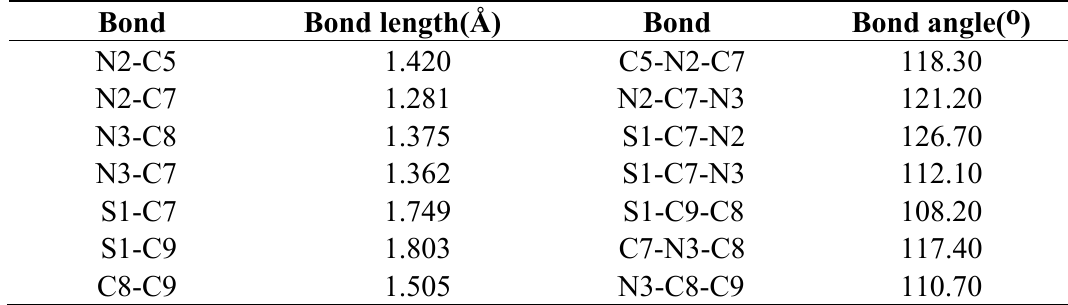
Table 1. Selected bond lengths and bond angles for 3a .